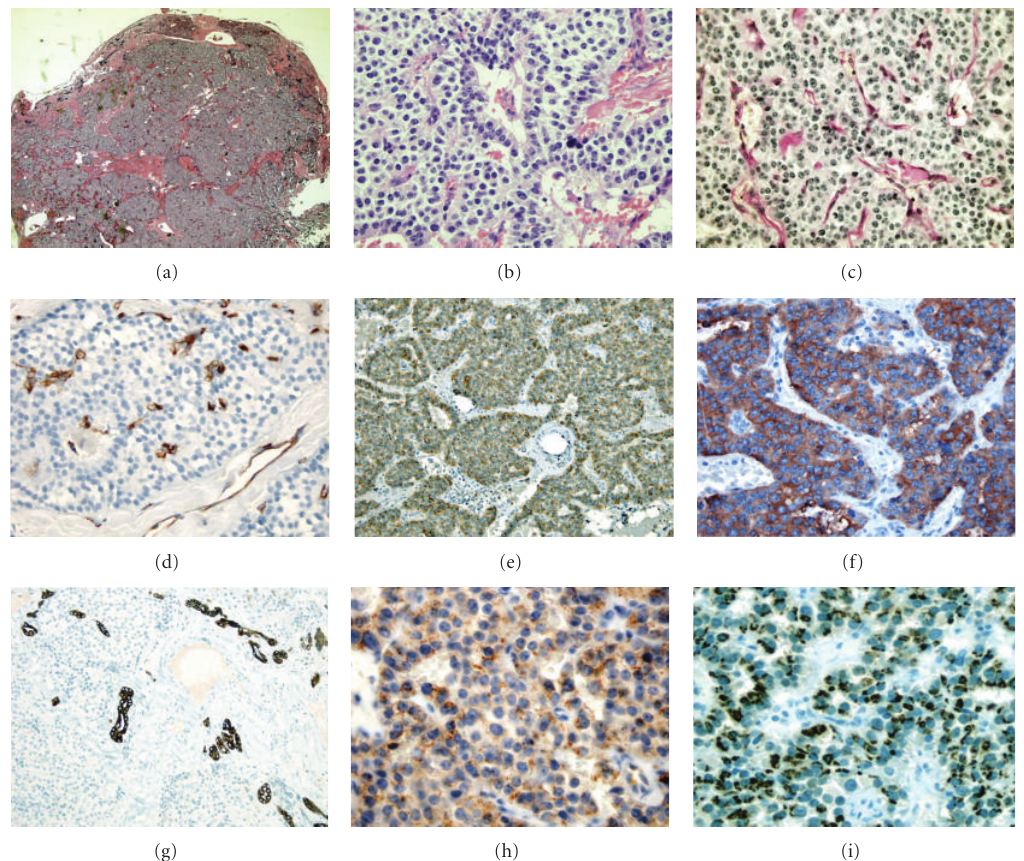
Figure 2: Histopathological analysis of the surgical specimen. (a) Hematoxylin and eosin staining (low magnification) showing gross appearance of the tissue and presence of a pseudocapsule with variable thickness. (b) Hematoxylin and eosin staining (200x) showing monomorphic cells with abundant granular cytoplasm and central nuclei, in contact with capillary basement membranes, stained with Period-Acid Schi ff (PAS) reaction (c, 200x). (d) Capillaries are stained with anti-CD34 (200x). The strong chromogranin (e) and Synaptophysin (f) immunoreactivity indicates a neuroendocrine origin, while the few areas staining for cytokeratin-7 (g) are residual exocrine tissue (100x). A visual comparison between insulin (h) and proinsulin (i) staining (200x) suggests a stronger proinsulin